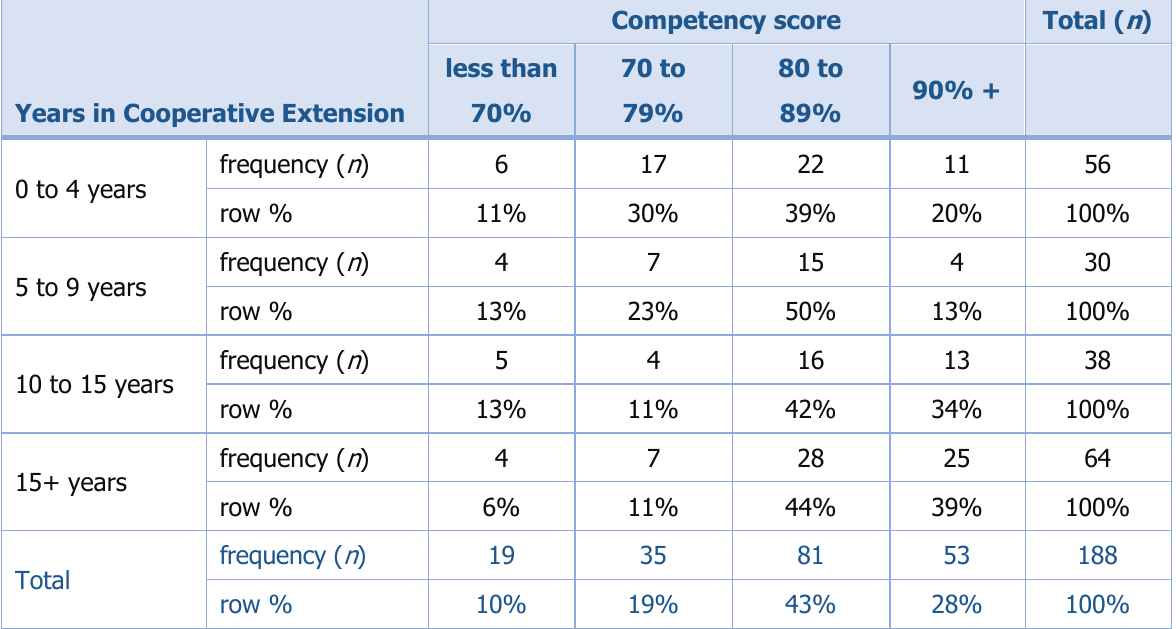
Table 3. Total Competency by Years in Cooperative Extension